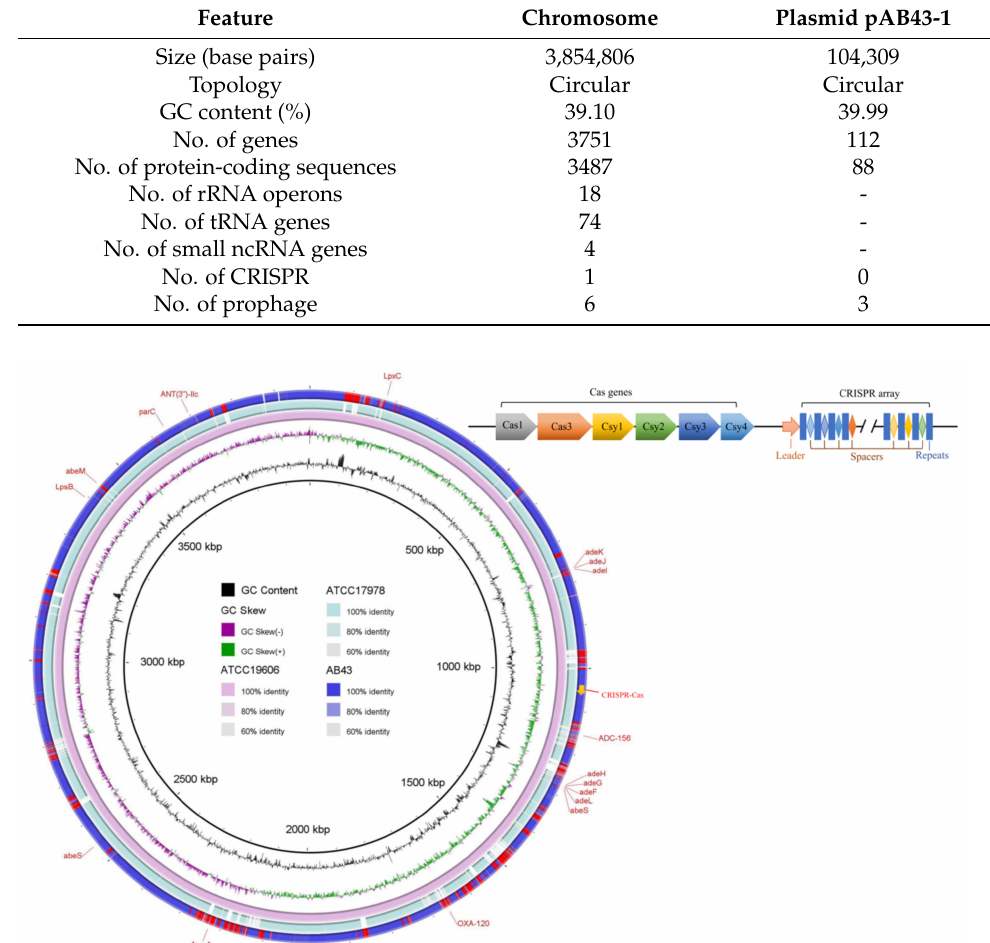
Table 1. General features of the A. baumannii strain AB43 genome.